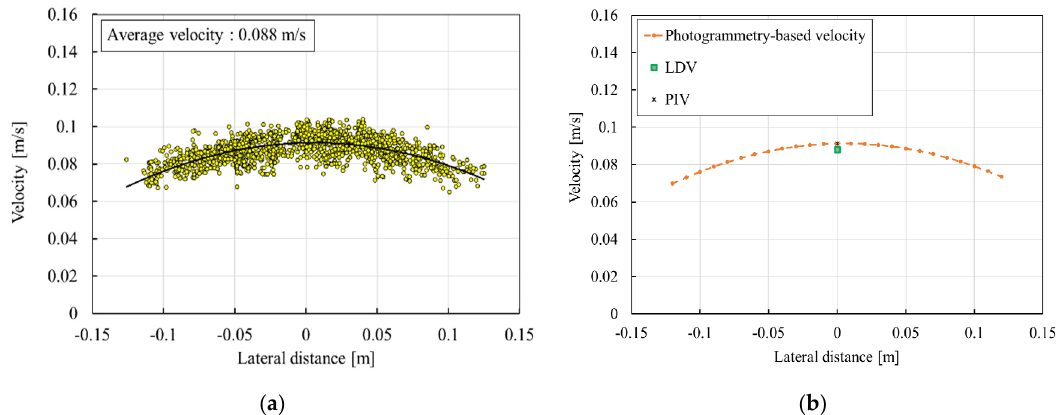
Figure 5. Surface velocity distribution in transverse direction: ( a ) Distribution of surface velocity and fitting curve. The circles present velocities of particles; ( b ) Comparison velocity profiles.